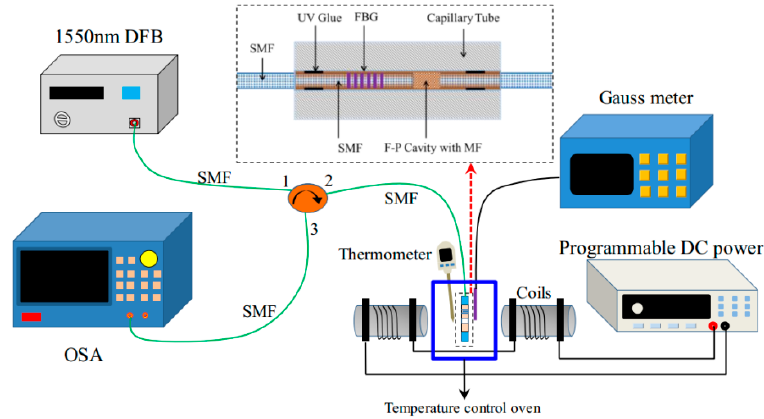
Figure 3. Experimental setup configuration for the FP-FBG sensing system. Inset: the cross-section schematic diagram of the FP sensing head.